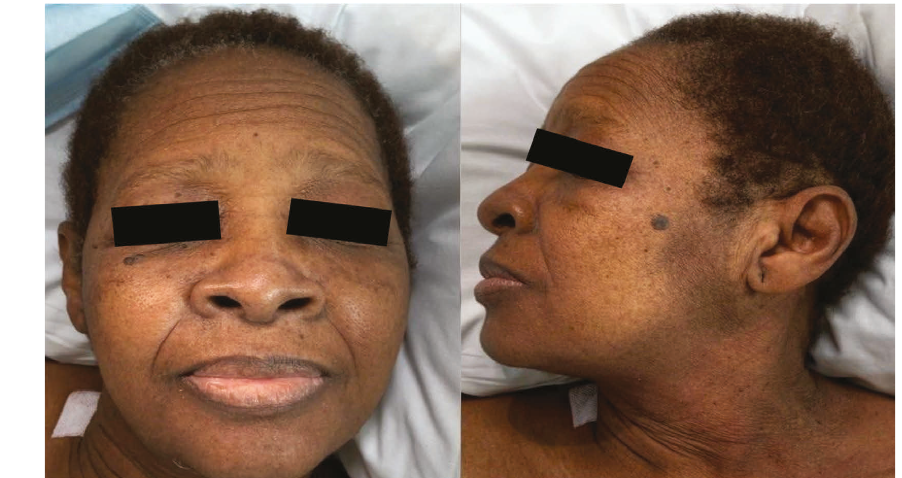
Figure 2: Periocular, perioral, cervical, and mandibular